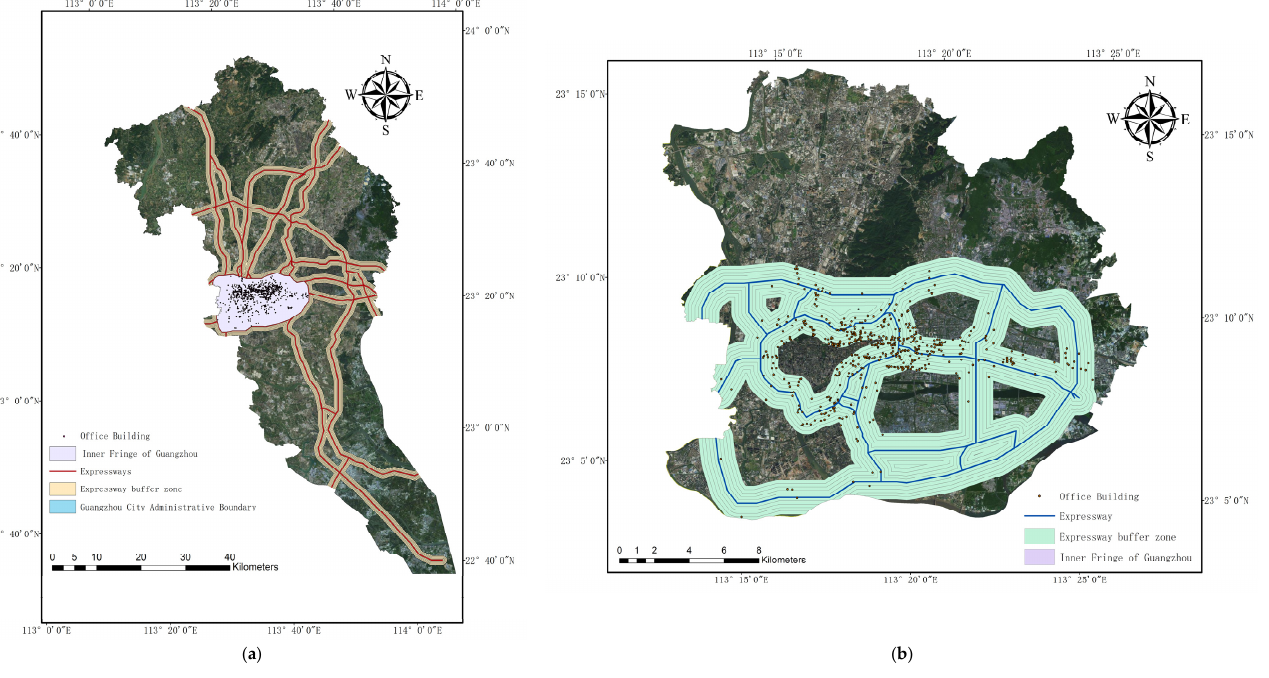
Figure 3. Distribution of expressway: ( a ) expressway outside the inner-fringe area; ( b ) expressway in the inner-fringe area.